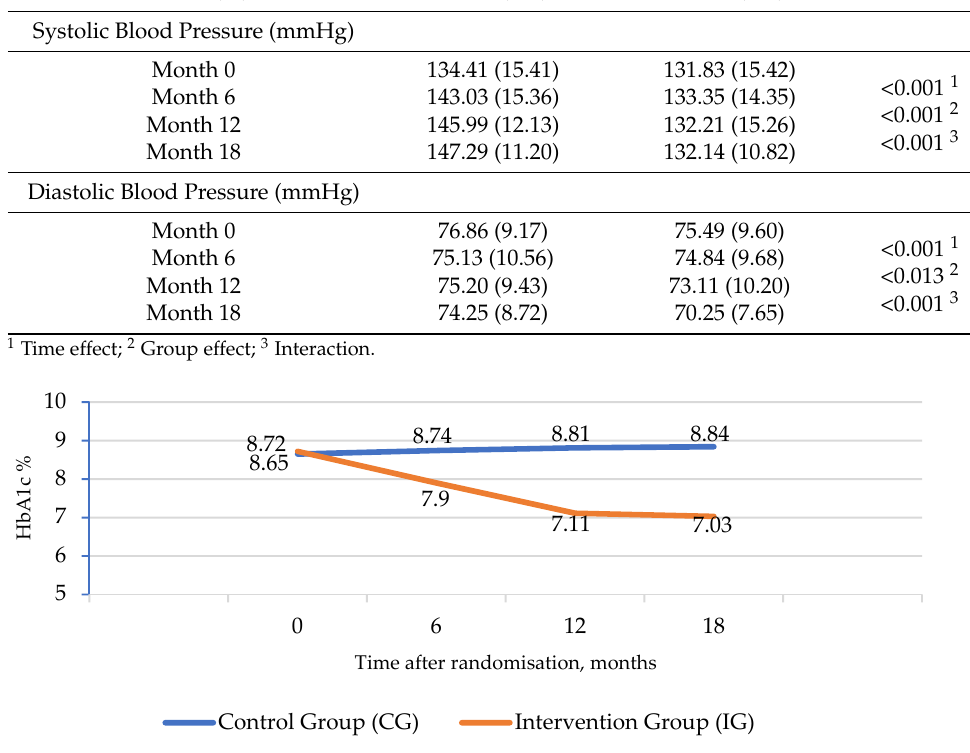
Figure 2. Evolution of HbA1c in the two groups of the RCT study (data extracted from Table 2). Secondary outcomes: included LDL-C and BMI. LDL-cholesterol: Mean values in- creased slightly over the trial 18-months follow-up in the CG (117.07 mg/dL month 0; 125.87 mg/dL month 18); the IG values decreased at the end of the trial but slightly in- creased between months 12 and 18. Test values were significant ( p < 0.001) in the three cases, both in the comparison by time and between groups as well as in the interaction of both factors (Table 2). Mean BMI values of both CG and IG groups at month zero were similar (around 30), while in the CG, there was a slight increase (30.49 at month 0; 30.78 at month 18; difference: plus 0.29), the mean BMI in the IG decreased slightly and progressively during follow-up (30.42 at month 0; 30.05 at month 18; difference: minus 0.37). BMI was the variable that was proven to remain the most constant over time in the IG. Mean systolic blood pressure in the CG increased by almost thirteen points (134.41 mmHg month 0; 147.29 mmHg month 18), but only slightly in the IG (difference: 0.31 points). The evolution of the mean diastolic blood pressure values of both groups at different times had similar behaviour, decreasing slightly, although more so in the IG. In the CG, the total difference between the initial and final time was 2.61 points, while in the IG, it was 5.24 points. In the respective statistical tests, significant differences were obtained in both the comparison by time and by group as well as in the interaction p < 0.001 (in the latter, the significant differences occurred between the groups from month 12 onward) (Table 2) (Figures 3 and 4). Psychological outcomes: Table 3 shows the evolution of the trial results regarding psychological outcomes. At month 0, patients who indicated clinical signs and symptoms compatible with major depression (PHQ-9 cut-off criteria) were 28% of the population, 34% with minor depression, and 38% had no symptoms of